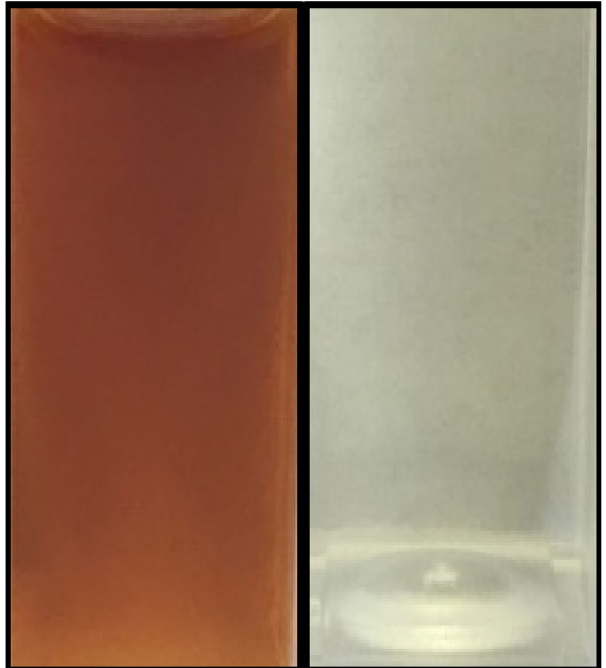
Figure 4. Dark brown-reddish color of the reaction mixture (Left) after a reaction time of 4 h using cellulose and a borosilicate glass reactor containing 1645 ppm HMF and 125 ppm levulinic acid (Right) Transparent color of a standard solution of 2000 ppm HMF and 2000 ppm levulinic